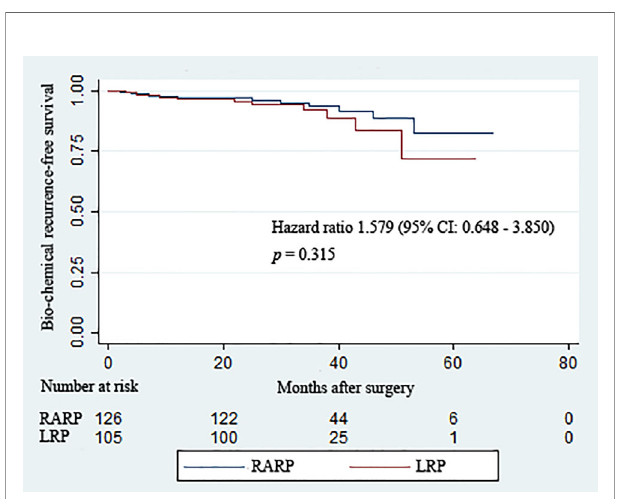
FIGURE 1 | Kaplan – Meier curves showing the biochemical recurrence-free survival rates following robot-assisted and laparoscopic radical prostatectomy for prostate cancer with a large prostate volume over the follow-up duration.